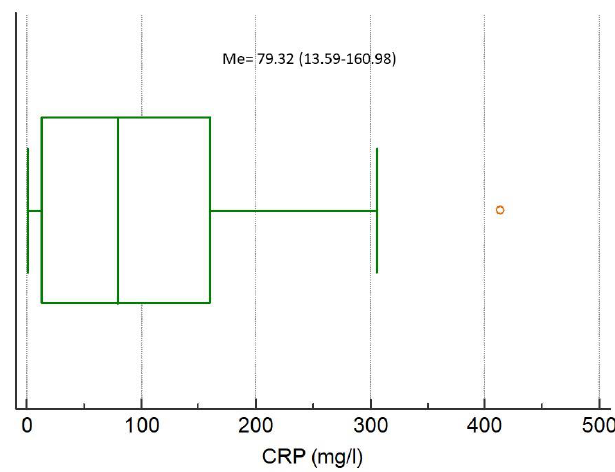
Figure 1. Distribution of the C-reactive protein (CRP) concentrations in the study population. Circles indicate outliers and far out values illustrated as single data points.